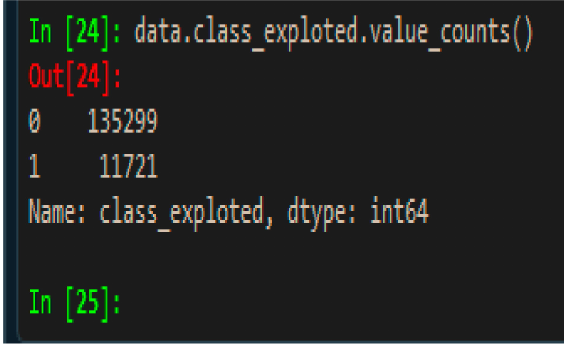
Figure 4. Existing class